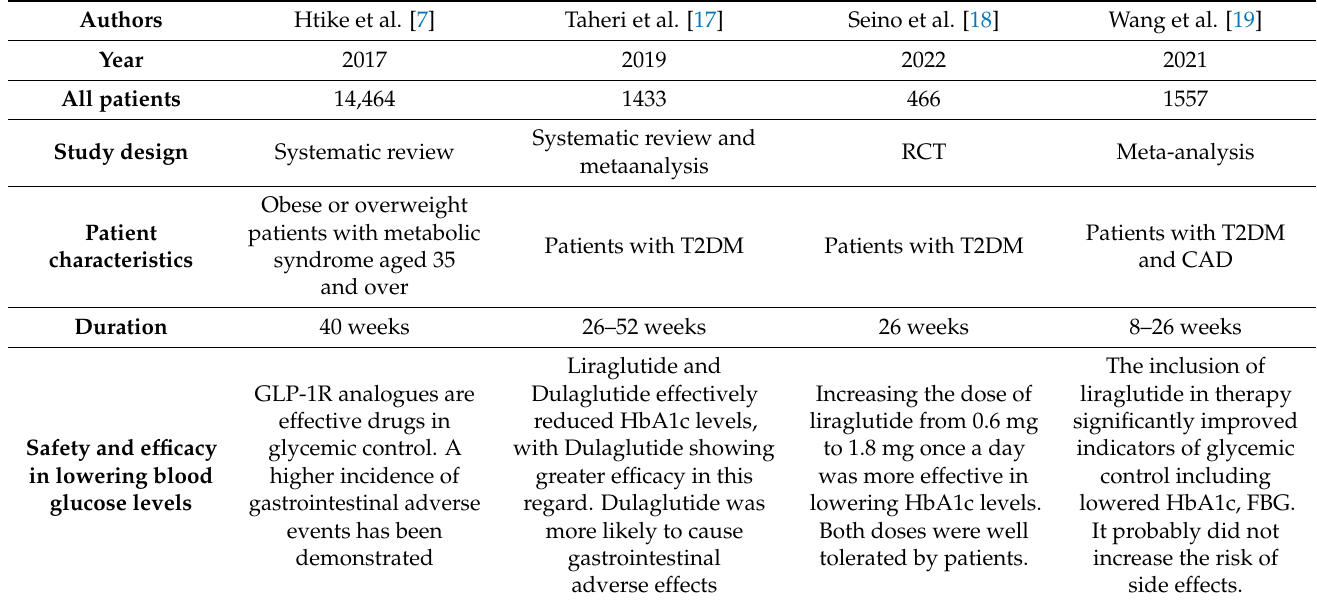
Table 2. Comparison of efficacy and safety of GLP-1 receptor agonists from the described studies